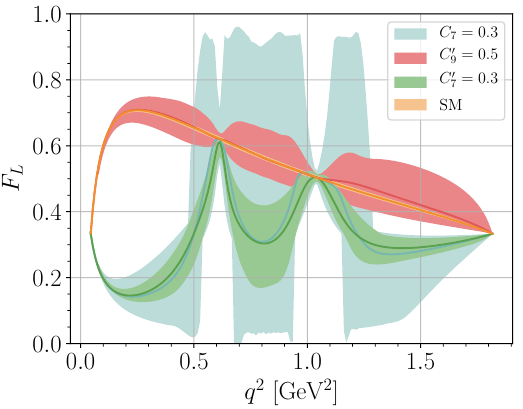
Figure 4 . The fraction of longitudinally polarized dimuons F L of Λ c → pµ + µ − decays for various BSM contributions including theoretical uncertainties from form factors and resonance parameters. The orange band corresponds to the resonant SM